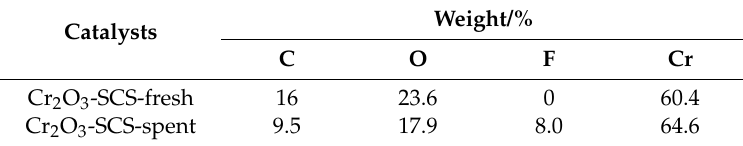
Table 4. Surface composition of fresh and spent Cr 2 O 3 -SCS determined by X-ray energy spectrometer